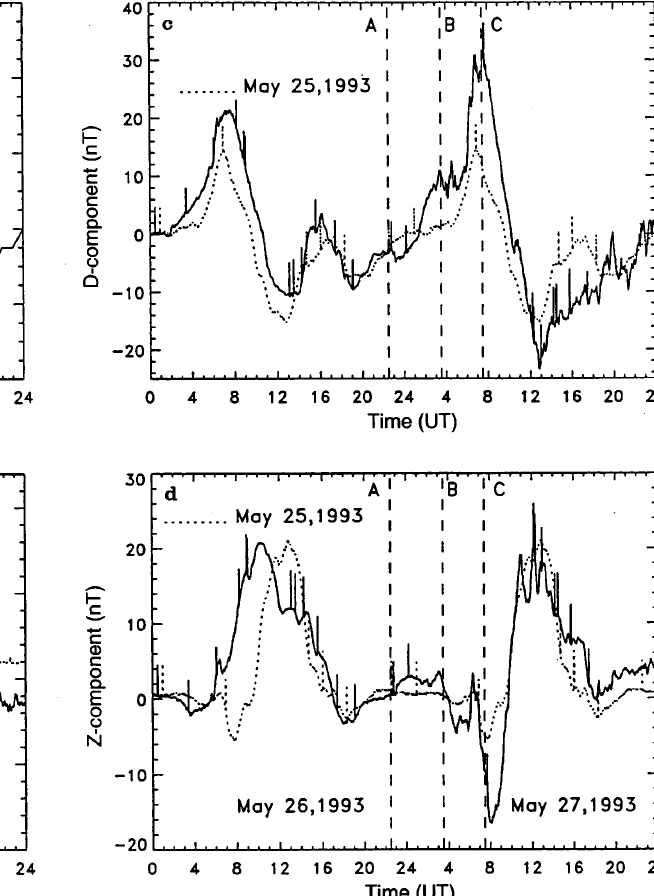
Table 2. Geophysical context of the case-study day equatorial Dst extrema